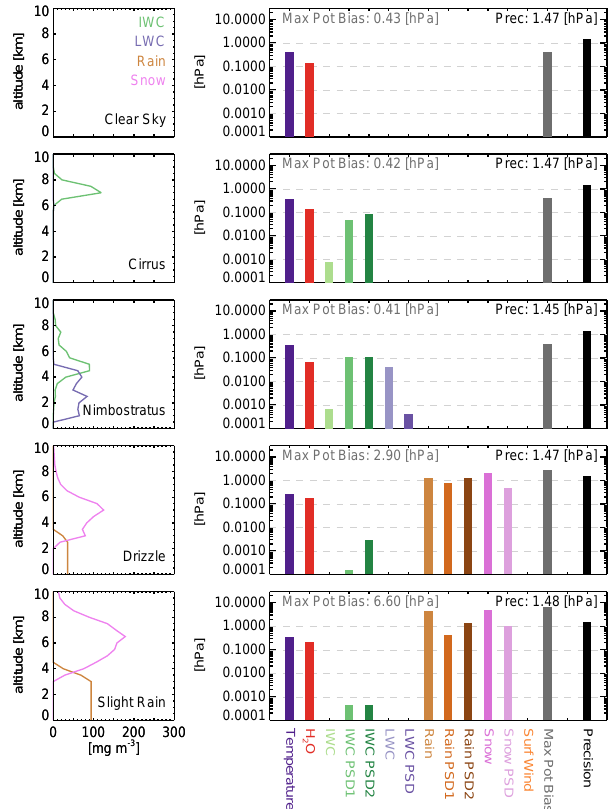
Figure 6. Systematic error estimates caused by each of the sources described in Table 1 as well as the precision and maximum poten- tial bias for five different scenarios (clear sky, cirrus, nimbostratus, drizzle, and slight rain). The maximum potential bias is the root- sum-square combination of all the error sources shown. These sim- ulations were performed using 52.8 and 54.8GHz radar tones; sim- ulations using optimum frequencies are shown in Fig.